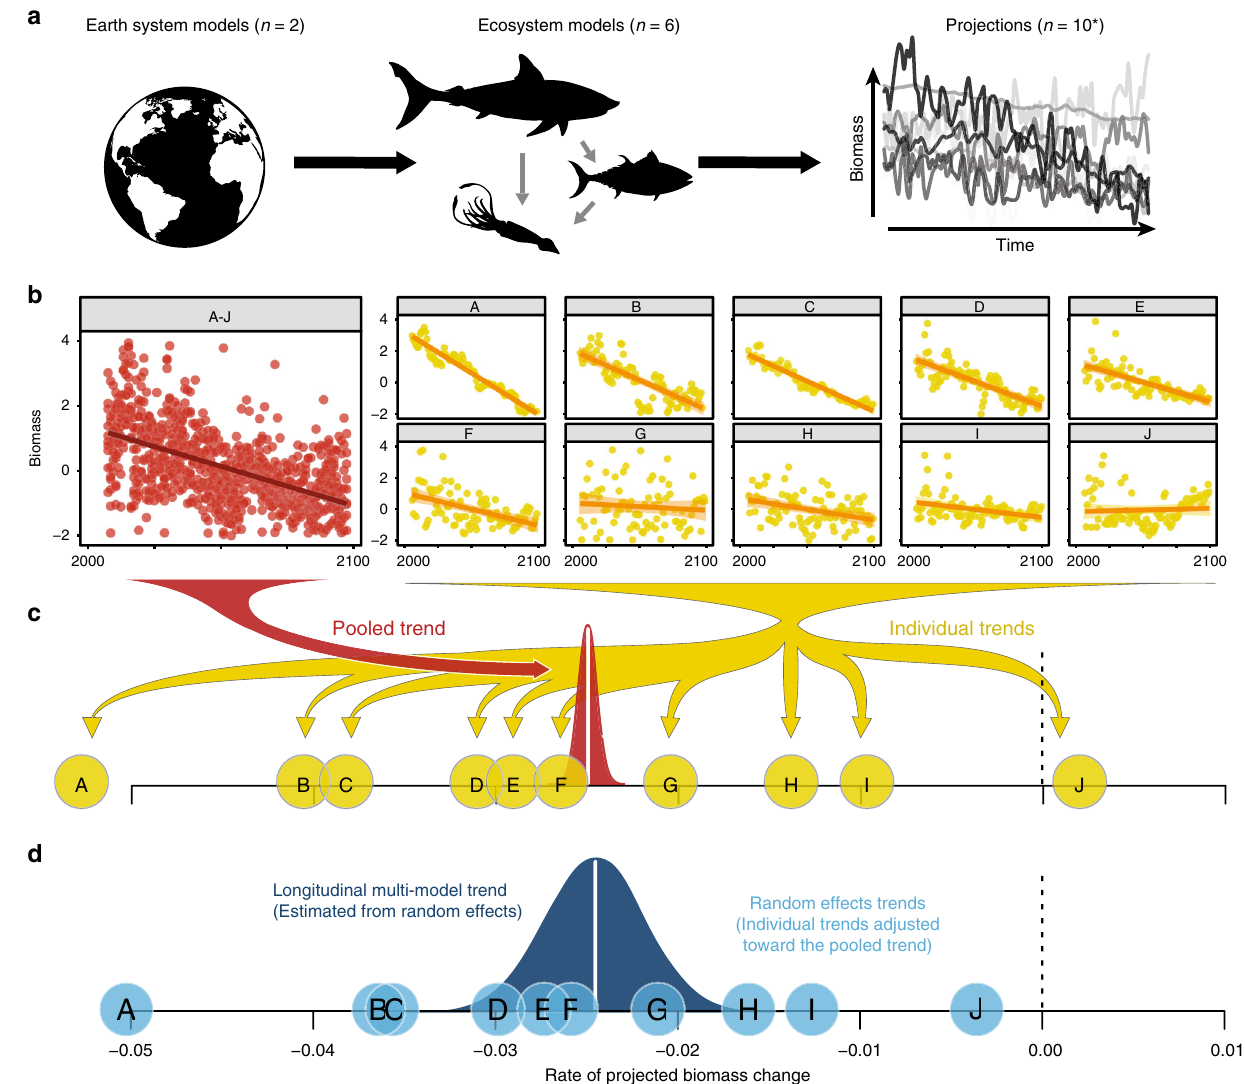
Fig. 1 Projecting ecological change. a Projections of marine animal biomass under different emission scenarios are obtained by coupling the standardized output from two earth system models to six global marine ecosystem models. b Biomass trends (lines) are estimated from model projections (points) individually (yellow) and collectively in a single pooled sample (red). c Individual time trends (yellow shaded circles) are adjusted toward the pooled trend (red shaded density) according to their distance from it and their variability; more variable trends that are far from the pooled trend are adjusted the most (e.g., J). d Adjusted individual trends or random effects predictions (blue points) are used to derive the multi-model longitudinal biomass trend, and its statistical uncertainty (blue shaded density). The overall trend distribution often has a similar mean but a signi fi cantly larger variance than the pooled or individual